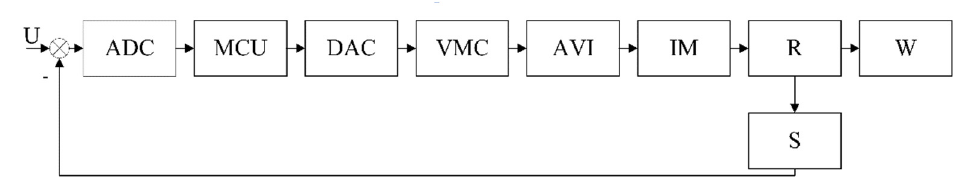
Figure 2. Electric actuator schematic diagram.